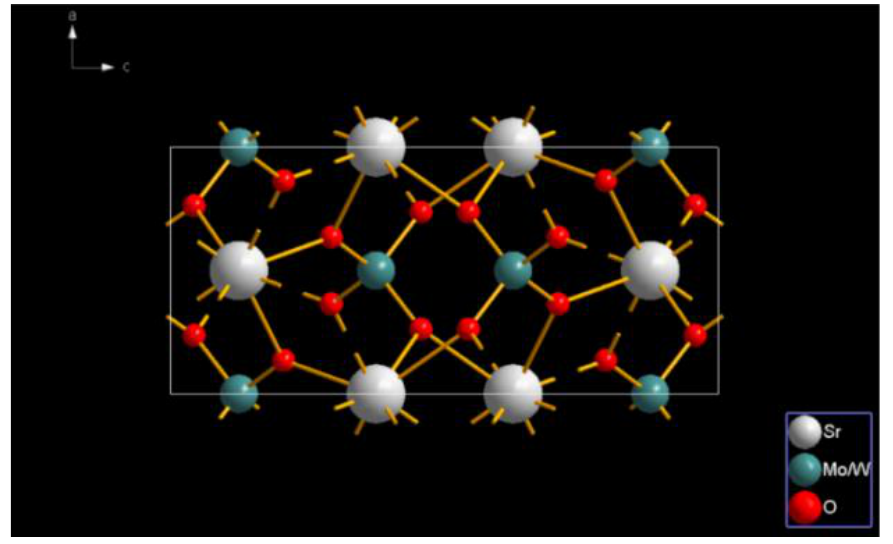
Figure 4. Crystal structure of SrMo 0.5 W 0.5 O 4 . The FT-IR spectrum of the sample SrMo 0.5 W 0.5 O 4 was obtained by the KBr pressed disc method. As shown in Figure 5, the FT-IR spectra of the prepared samples have absorption peaks at 818 cm − 1 , 1630 cm − 1 , and 3420 cm − 1 , where the absorption peak at 818 cm − 1 corresponds to the stretching vibration of O-W/Mo-O, indicating the existence of WO 42 − and MoO 42 − groups in the prepared samples. The absorption peaks at 1630 cm − 1 and 3420 cm − 1 are respectively attributed to the bending and stretching vibrations of O-H, causing the water vapor on the surface of the SrMo 0.5 W 0.5 O 4 surface sample.